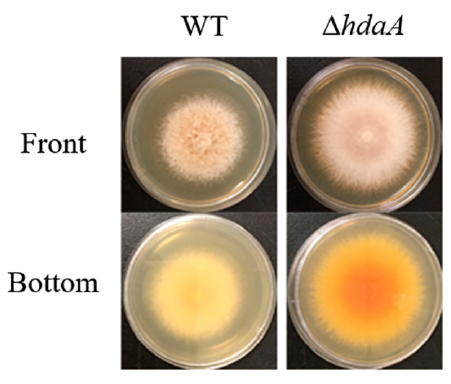
3.2. Analysis of Phenotypic and Secondary Metabolite Profile of ∆ hdaA Mutant of A. terreus RA2905 The ∆ hdaA mutant strain displayed phenotypic differences compared to WT when cultured in solid potato dextrose media (PDA). The ∆ hdaA mutant produced approximately 50% more conidia than WT, and a sienna pigment emerged in ∆ hdaA mutant but not in WT (Figure 2). The HPLC analysis of EtOAc extracts of the ∆ hdaA mutant and the WT cultured in potato broth showed that loss of HdaA greatly altered the secondary metabolic profile of A. terreus RA2905. The hdaA deletion mutant synthesized three folds more butyrolactone I than WT (Figure 3), indicating that hdaA has a negative regulatory effect on the biosynthesis of butyrolactone I in A. terreus . It should be mentioned that TLC analysis exhibited two new fluorescent yellow spots in the fungal extract of ∆ hdaA , but not in WT. Correspond- ingly, the HPLC profiles confirmed that the ∆ hdaA mutant produced new peaks at 41.0 and 42.4 min with distinctive UV maximum absorption wavelengths at 260 and 400 nm (Figures 4 and S17), which are not observed in WT. Then, the ∆ hdaA mutant was cultivated in a large scale to attempt the attainment of these newly produced compounds. From the EtOAc extract, five known compounds, including four butyrolactones (butyrolactones chromatography on silica gel and an ODS. Meanwhile, two new compounds ( 1 and 2 , Figure 5) were isolated using an ODS column eluted with 60% MeOH − H 2 O under the guidance of TLC with two fluorescent yellow spots, which were exactly the corresponding differential absorption peaks determined by HPLC analysis. Herein, compounds 1 and 2 were given the names asperterilone A and asperterilone B, respectively.